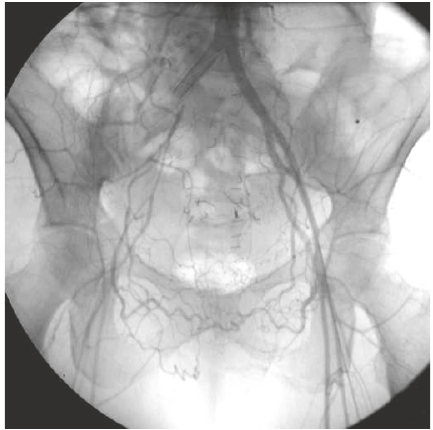
Figure 3: Arteriography of the aortoiliac intersection: endovascular prosthesis covered in place at the level of the right primitive iliac artery, a network of collateral arteries supplying the lower right